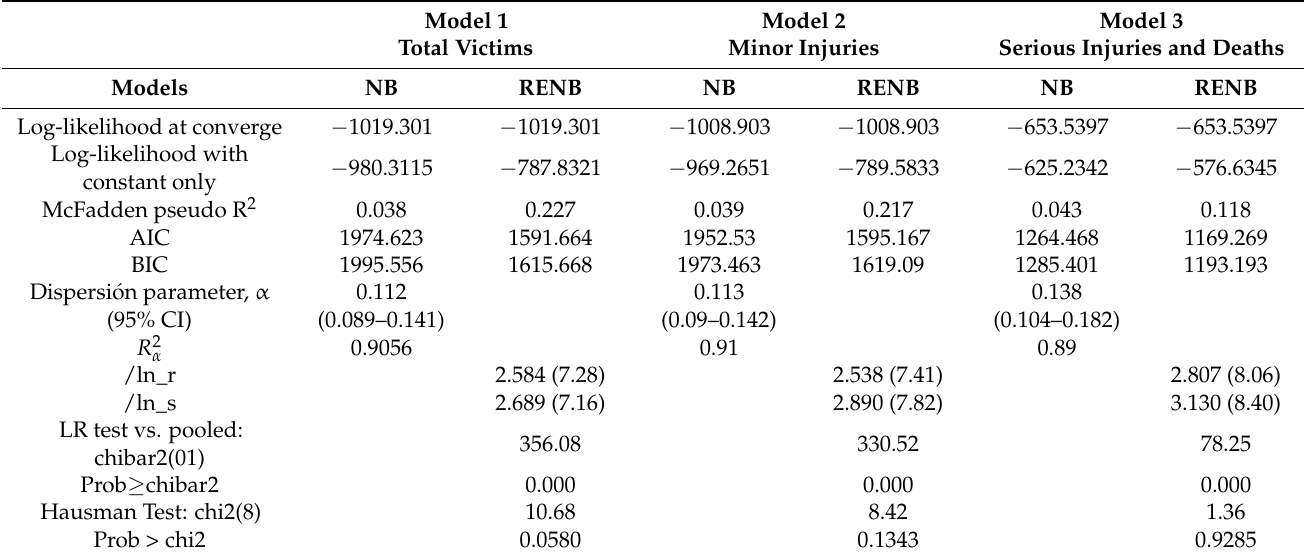
Table 5. Results of the fitted models. Source: own research.